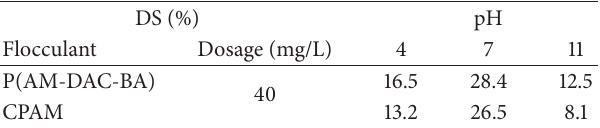
Table 5: Comparison of dewatering performance between P(AM- DAC-BA) and